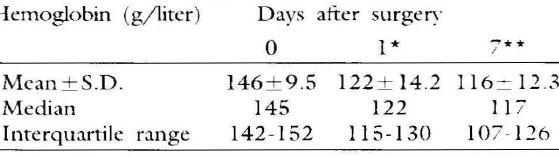
Table 1. Hemoglobin concentrations in t\\'ent\' \\'omen after abdominal hysterectomy Hemoglobin (g/liter) Days after surgef\' 0